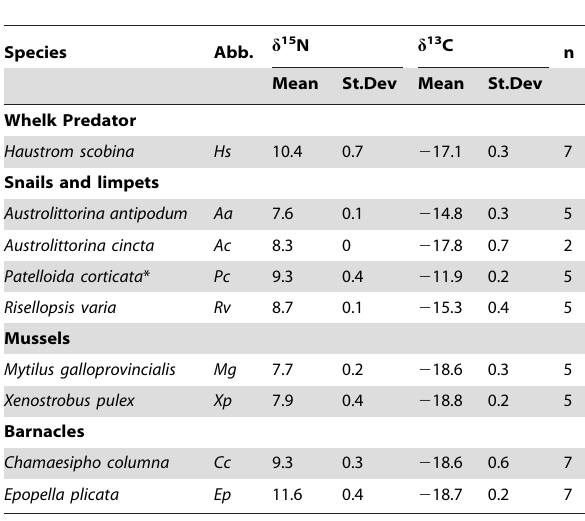
Table 2. Mean and standard deviation of species-specific isotopic signatures at Tauranga Head, New Zealand.